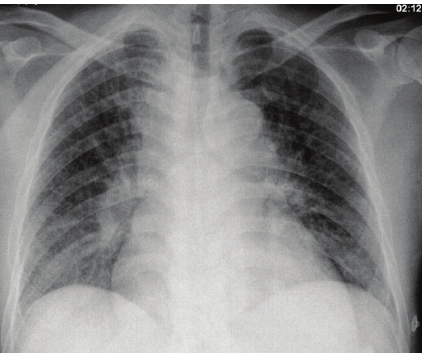
Figure 1: Roentgenogram of chest revealing bilateral reticular infiltrates with mediastinal widening suggestive of enlarged hilar and mediastinal lymph nodes. Enlarged cardiac shadow.